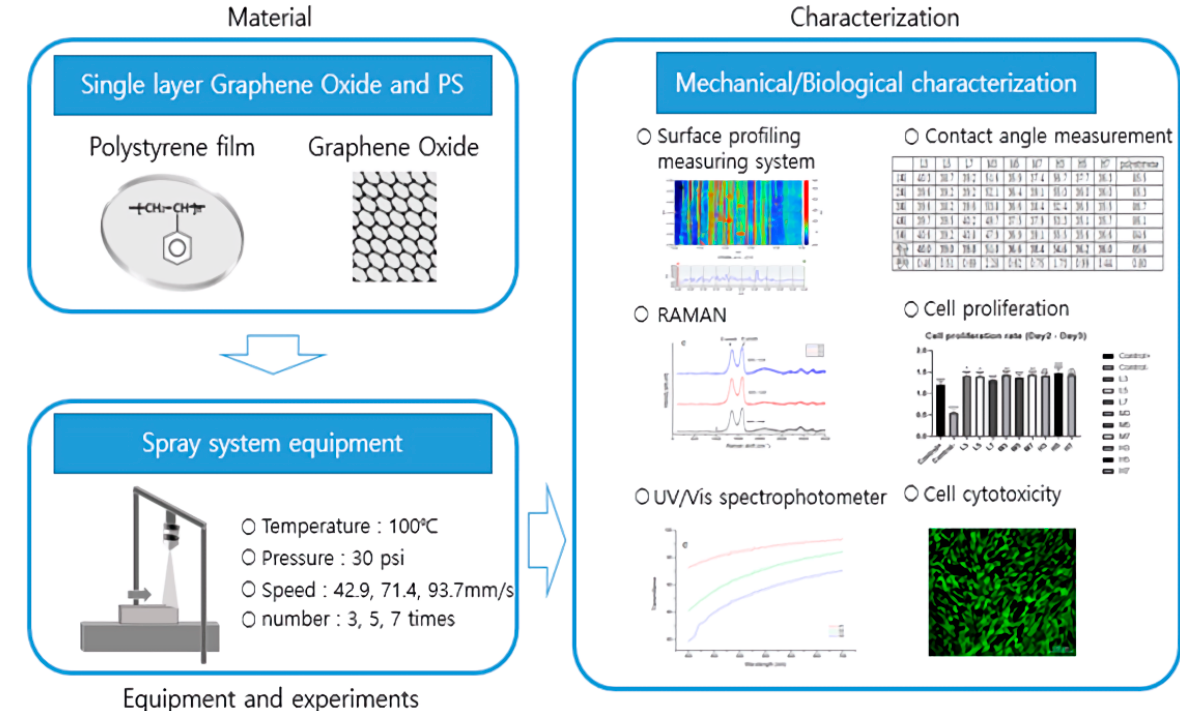
Figure 13. Schematic of the experiment.